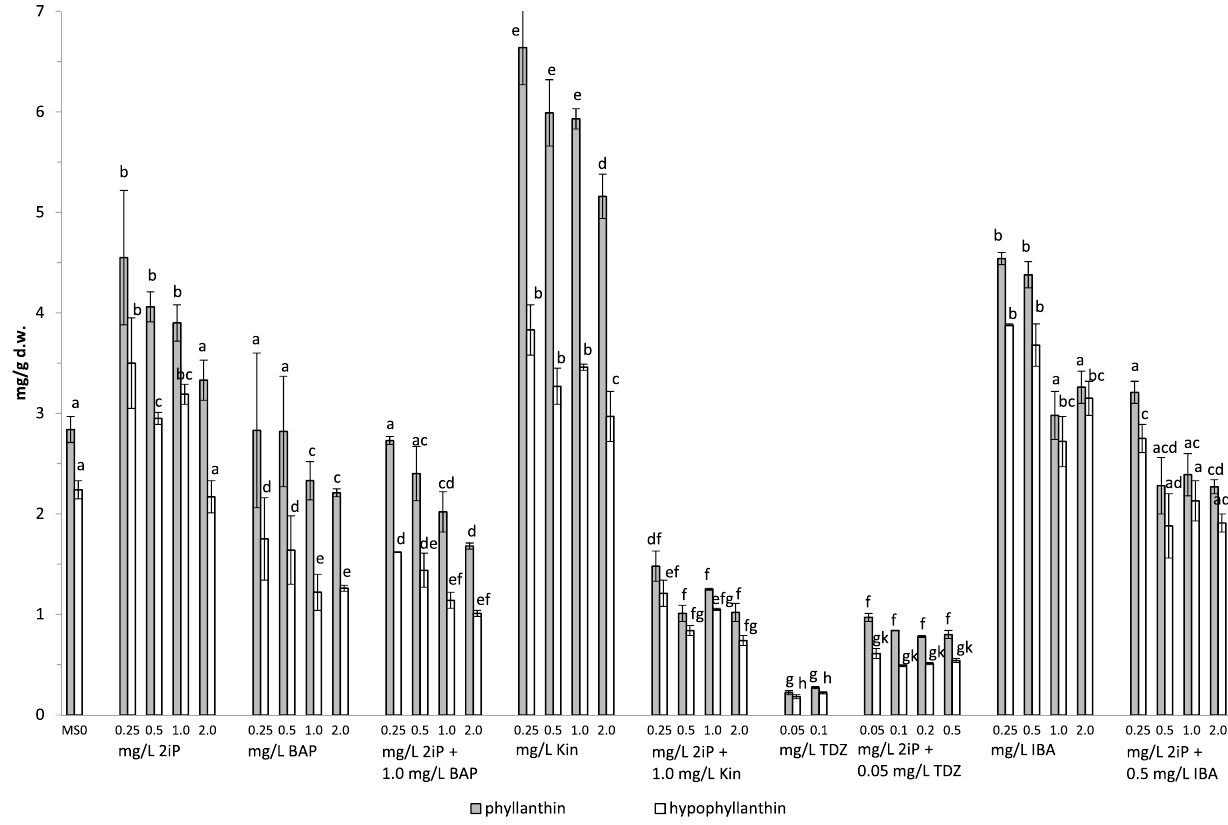
Figure 4. Effect of PGRs on the accumulation of lignans in P. amarus shoot culture. Different letters indicate significant differences between means (p < 0.05). n = 3 ±